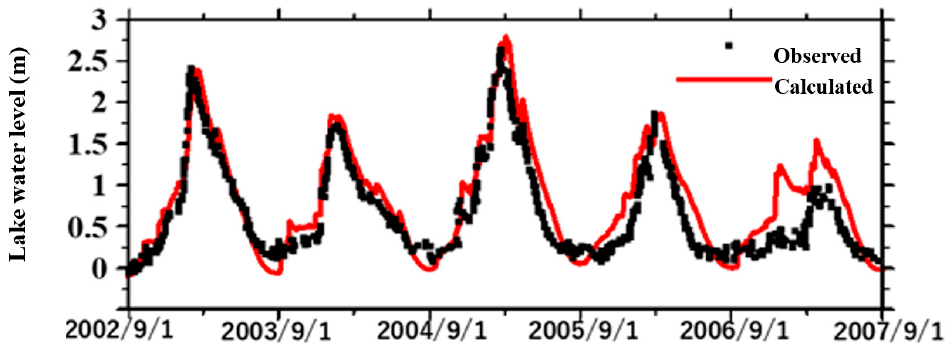
Figure 14. The simulated lake water level verified with the long term observed data.